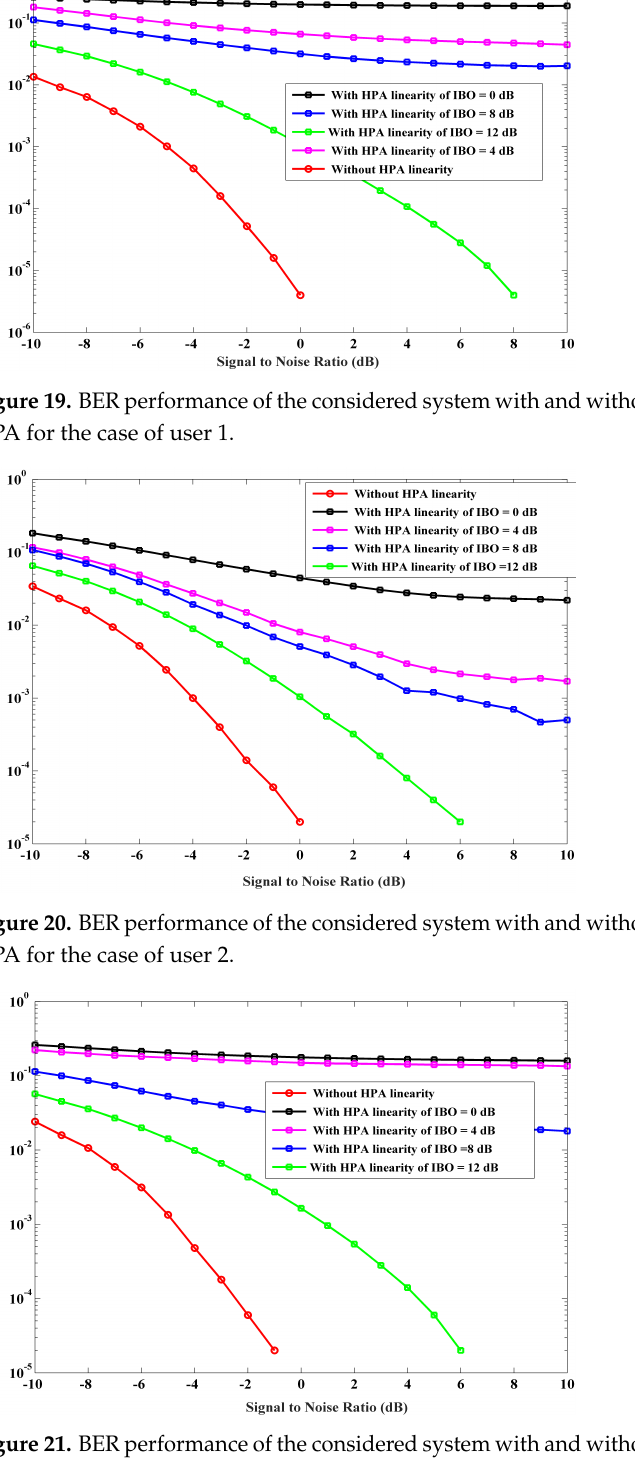
Figure 21. BER performance of the considered system with and without implementation of IBO-based HPA for the case of user